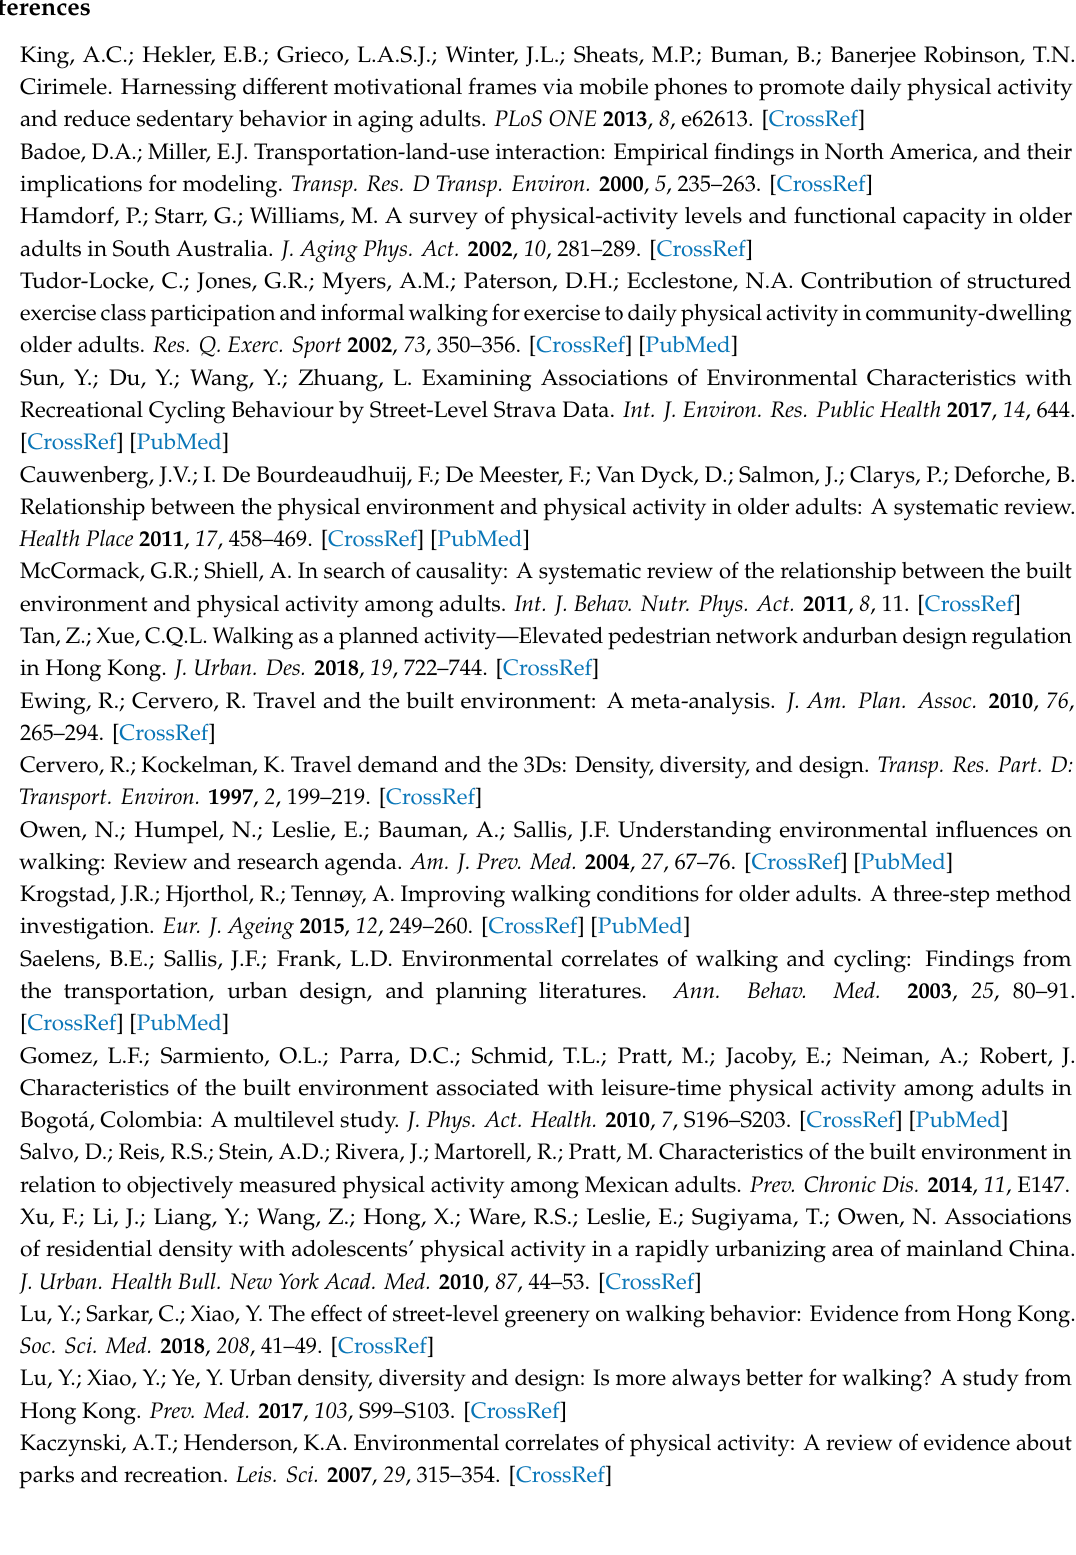
Table A1. Socio-demographic Characteristics. Gender: